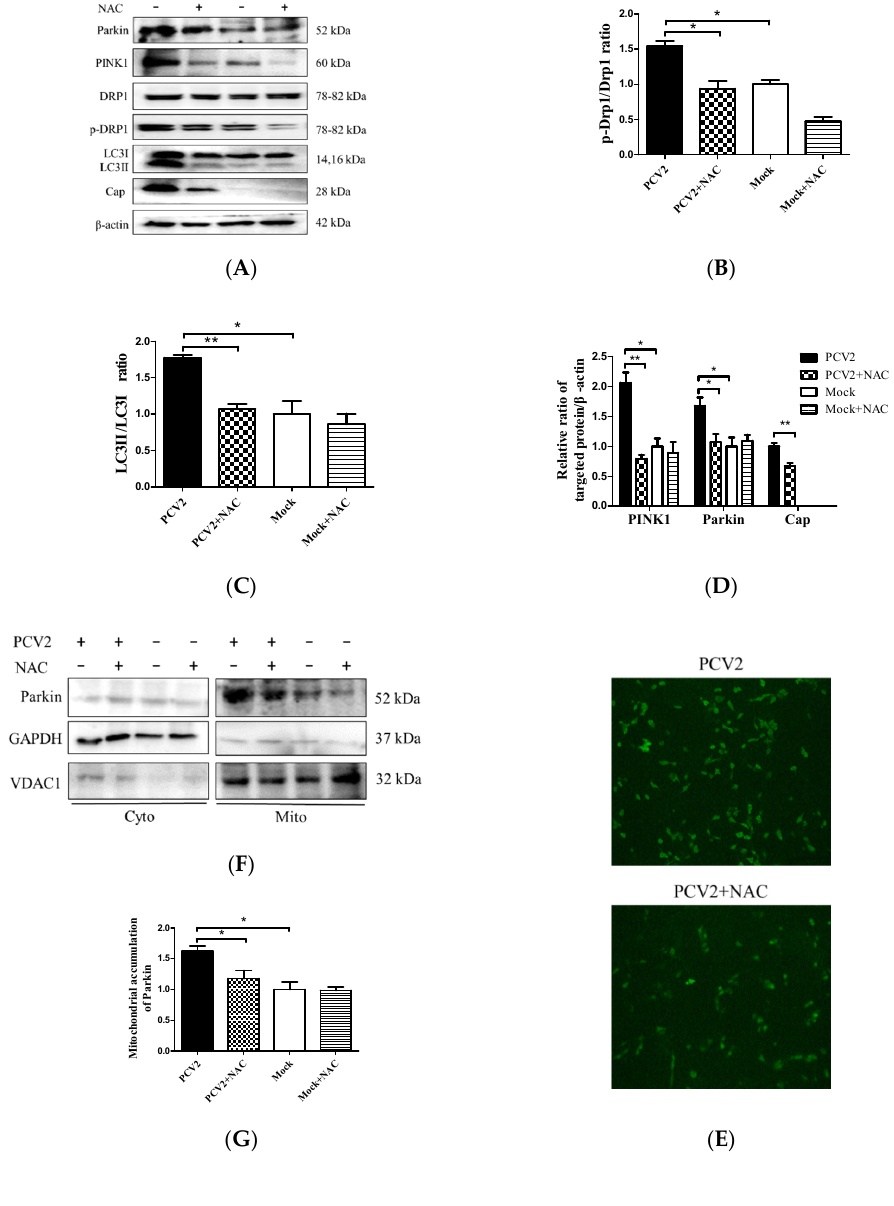
Figure 6. PCV2 increased the Drp1 phosphorylation, LC3II conversion, and PINK1 and Parkin expression, which could be down ‐ regulated using an N ‐ acetyl ‐ L ‐ cysteine (NAC) treatment. The PK ‐ 15 cells were infected with PCV2, treated with 10 mM NAC at 2 hpi, and then incubated for an additional 46 h before measuring the target protein expression using Western blotting or immunofluorescence. ( A ) Whole ‐ cell extracts were separated using SDS ‐ PAGE and analyzed using Western blotting with antibodies against Parkin, PINK1, Drp1, p ‐ Drp1 (Ser616), LC3 Ⅰ / Ⅱ , Cap, and β‐ actin. β‐ actin was used as a protein loading control. The gels shown here are representative of three individual experiments. ( B – D ) Ratio of p ‐ Drp1 to Drp1 ( B ); LC3 Ⅱ /LC3 Ⅰ ( C ); and PINK1, Parkin, and Cap to β‐ actin ( D ). ( E ) The PCV2 ‐ infected cells with or without NAC treatment were